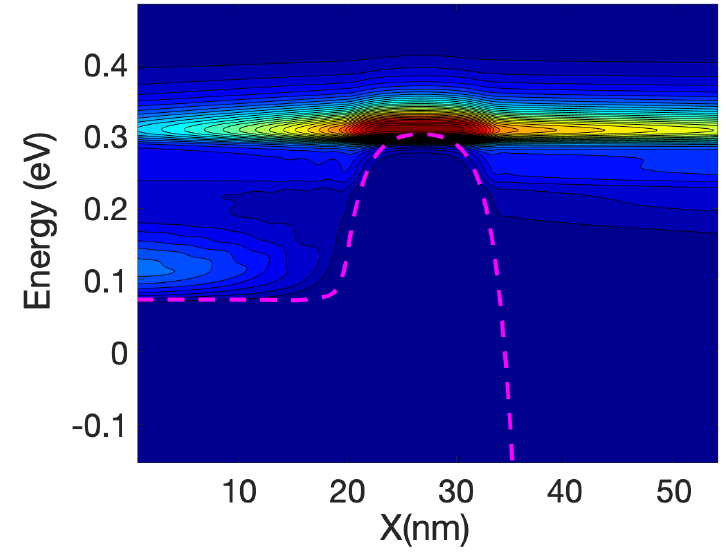
Figure 5. Energy resolved current spectra along the wire axis. The first sub-band is shown as a dashed line. The current at the source (in the left side of the figure) divides into two branches around energies 0.1 eV and 0.3 eV. The current in the low energy branch disappears when progressing from the source towards the right, vice-versa the current in the high energy branch increases. These means that the electrons from the lower energy branch are moving to the right branch. These electrons need to absorb phonons to increase their energies and therefore they tend to cool the lattice at the source.